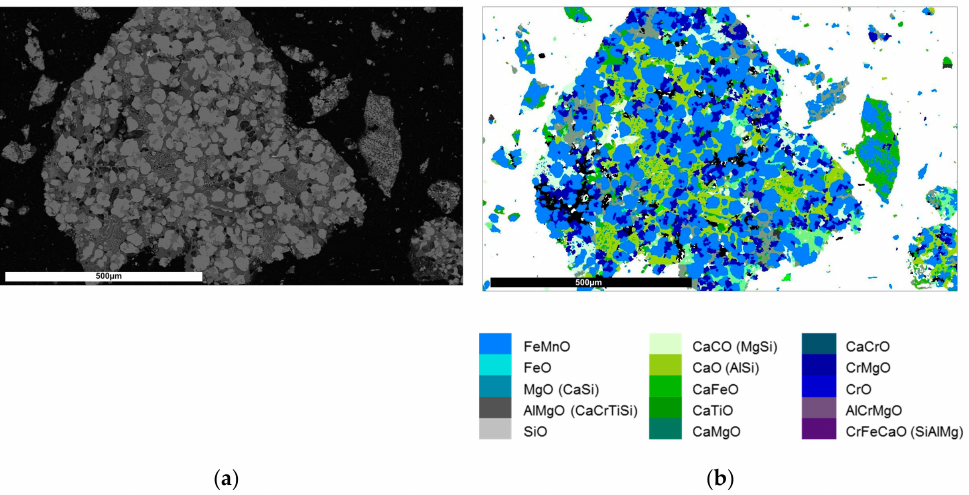
Figure 7. Illustration of mineral liberation analysis (MLA). ( a ): BSE and ( b ): color-coded picture of particles from the CS slag